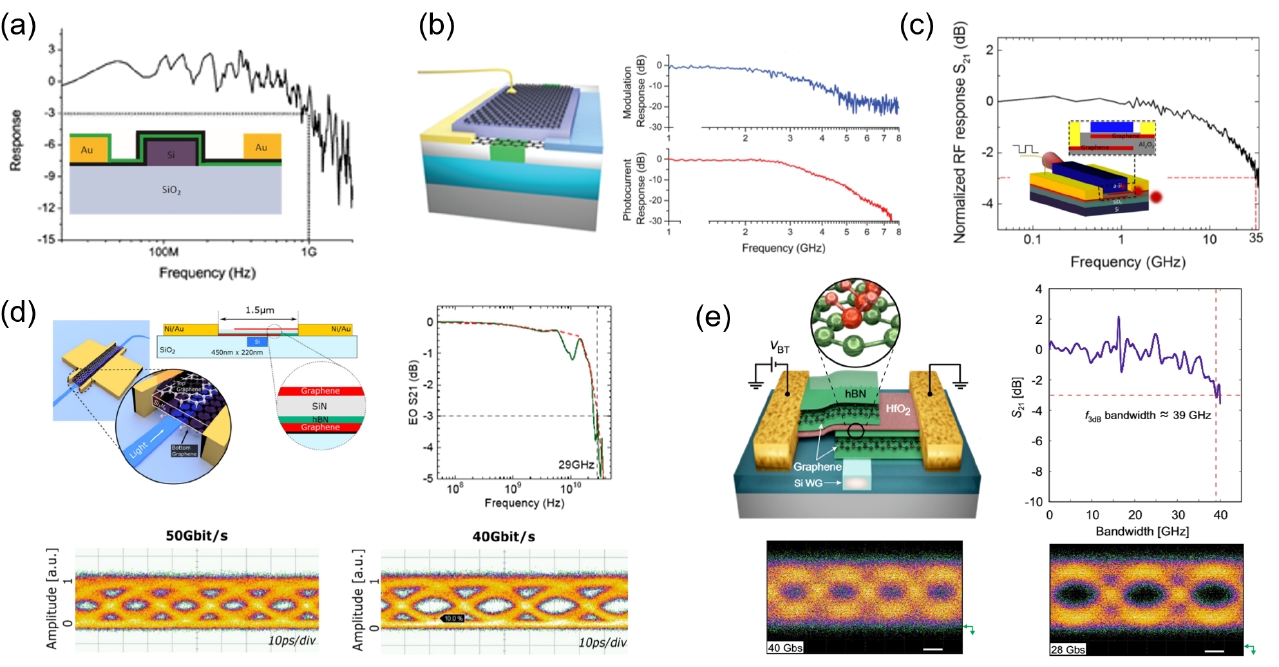
Figure 3. DLG − based EA modulator. ( a ) EO response of the DLG modulator with a 3 dB-bandwidth of ∼ 1 GHz. Inset: the corresponding structure of the first silicon-based DLG modulator device [34]. Reproduced from Ref. [34] with permission. ( b ) the dual-layer graphene modulator/detector inte- grated on a silicon waveguide and the correspondging frequency response of optical modulation and photodetection [55]. Reproduced from Ref. [55] with permission. ( c ) Athermal broadband DLG EO modulator based on a-Si waveguide with 35 GHz speed [56]. Reproduced from Ref. [56] with permission. ( d ) Schematic of the modulator consisting of a DLG capacitor integrated on the SOI platform. Electro-optical S21 responses of the DLG EA modulator with a 3 dB-bandwidth of 29 GHz. Open-eye diagrams operate at the rates of 40 Gbps and 50 Gbps [57]. Reproduced from Ref. [57] with permission. ( e ) 2D–3D integration of hexagonal boron nitride and a high- κ dielectric for ultrafast DLG EA modulator. The corresponding schematic cross-section of the EA modulator with an hBN-HfO 2 - hBN stacked dielectric. Measured electro-optical S21 frequency responses and non-return-to-zero (NRZ) eye diagrams at 28 and 40 Gbps [35]. Reproduced from Ref. [35] with